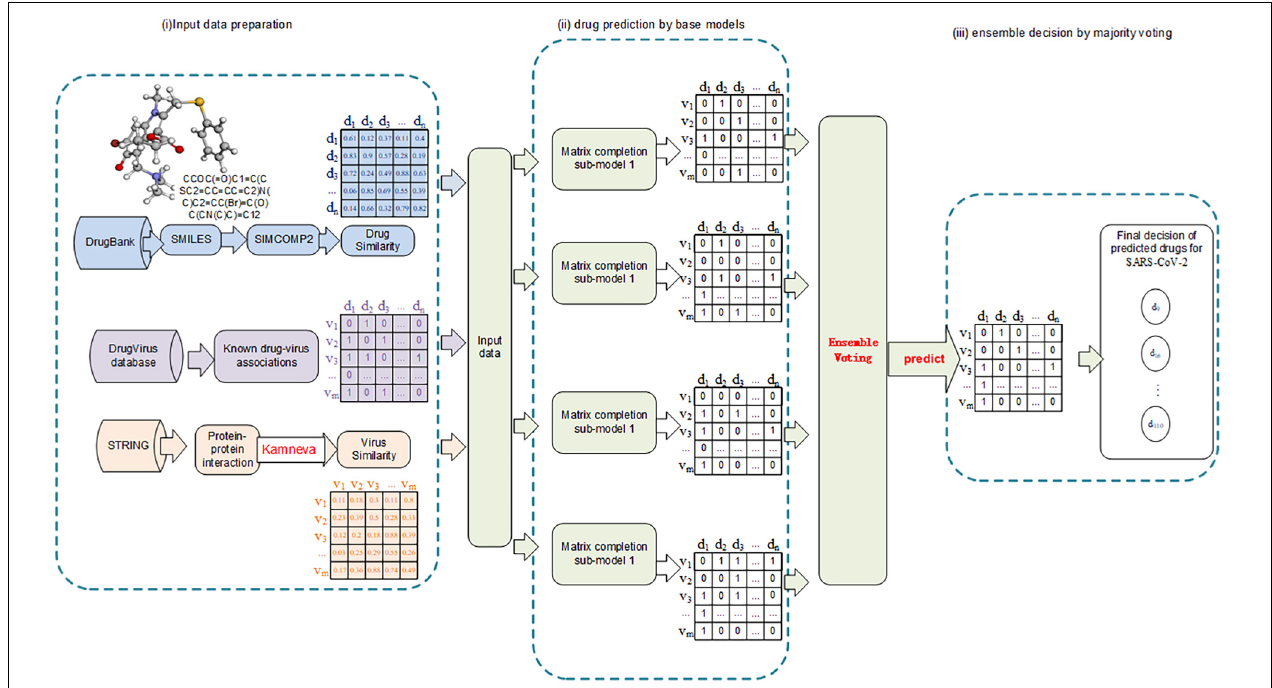
FIGURE 1 | Flowchart of our work.